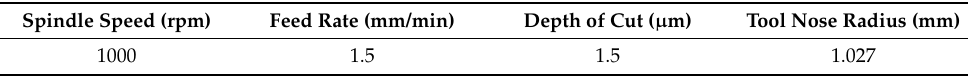
Table 1. Parameters of SPDT process.